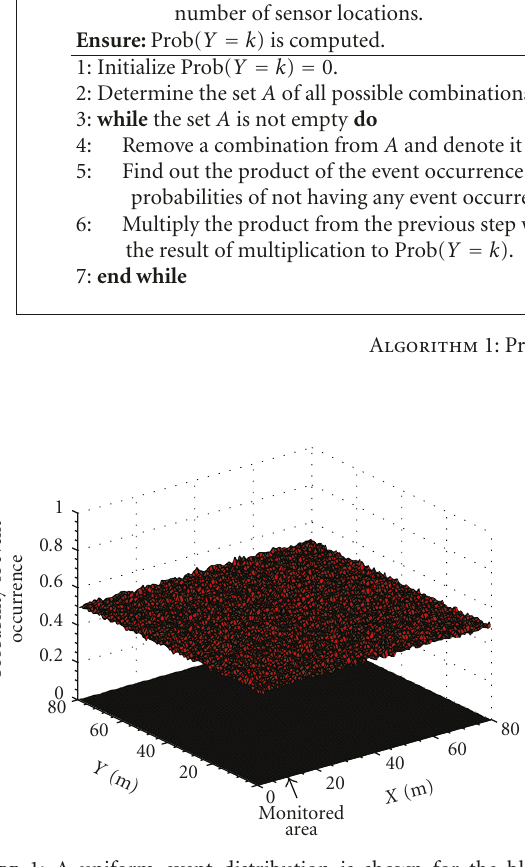
Figure 1: A uniform event distribution is shown for the black colored monitored area. A nonzero event occurrence probability at any point is indicated in red